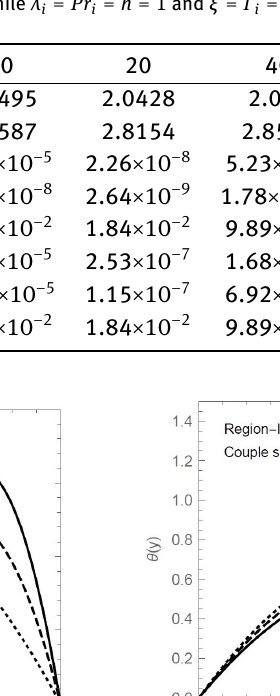
= −0.477, (cid:126) u = 1 2